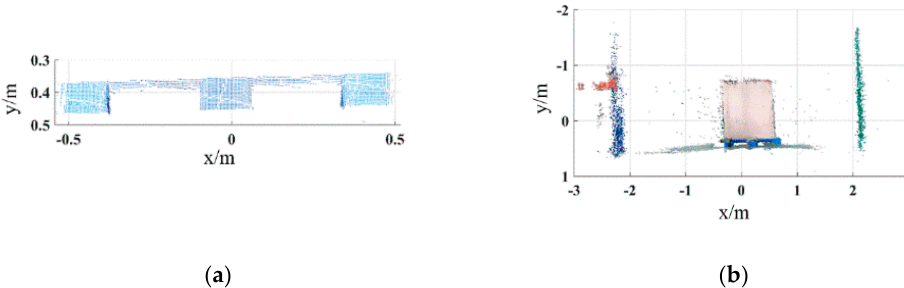
Figure 12. Pallet template point cloud and original ground scene point cloud. ( a ) Pallet template point cloud. ( b ) Original ground scene point cloud.